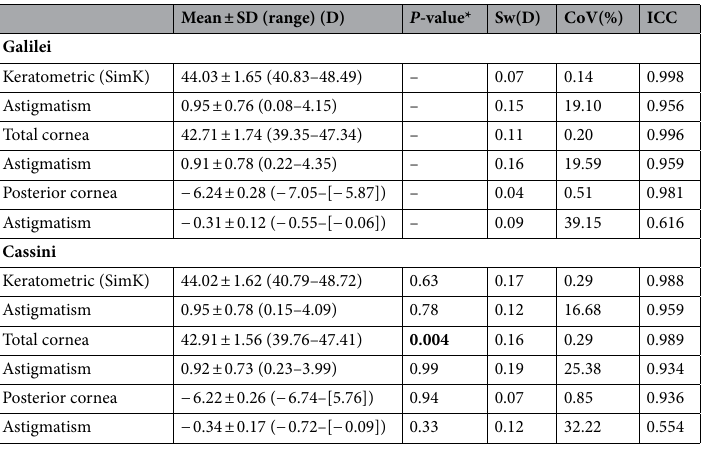
Table 1. Comparability and intra-observer repeatability for corneal power and astigmatism obtained from the Cassini and Galilei G4 in normal eyes. Comparisons of corneal power and astigmatism obtained from the Cassini and Galilei G4 in normal eyes. simK = simulated keratometric; Sw = within-subject standard deviation, CoV = coefficient of variation, and ICC = intra-class correlation coefficient. Signifcant values with P < 0.05 are in bold. Values are expressed as mean ± SD. * P values comparing mean values between Cassini and Galilei, and bold value indicating P < 0.05.